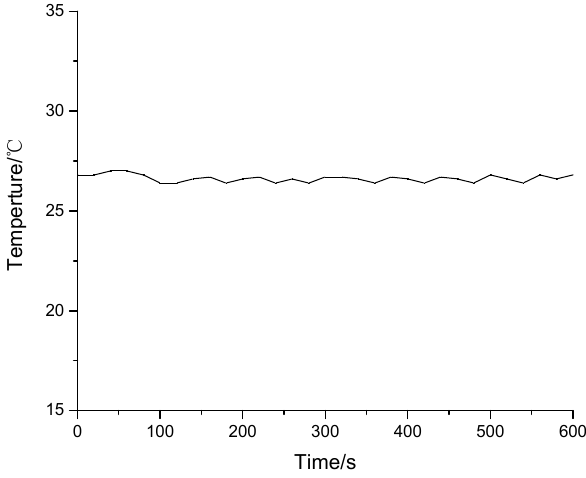
Figure 5. Temperature monitoring data.